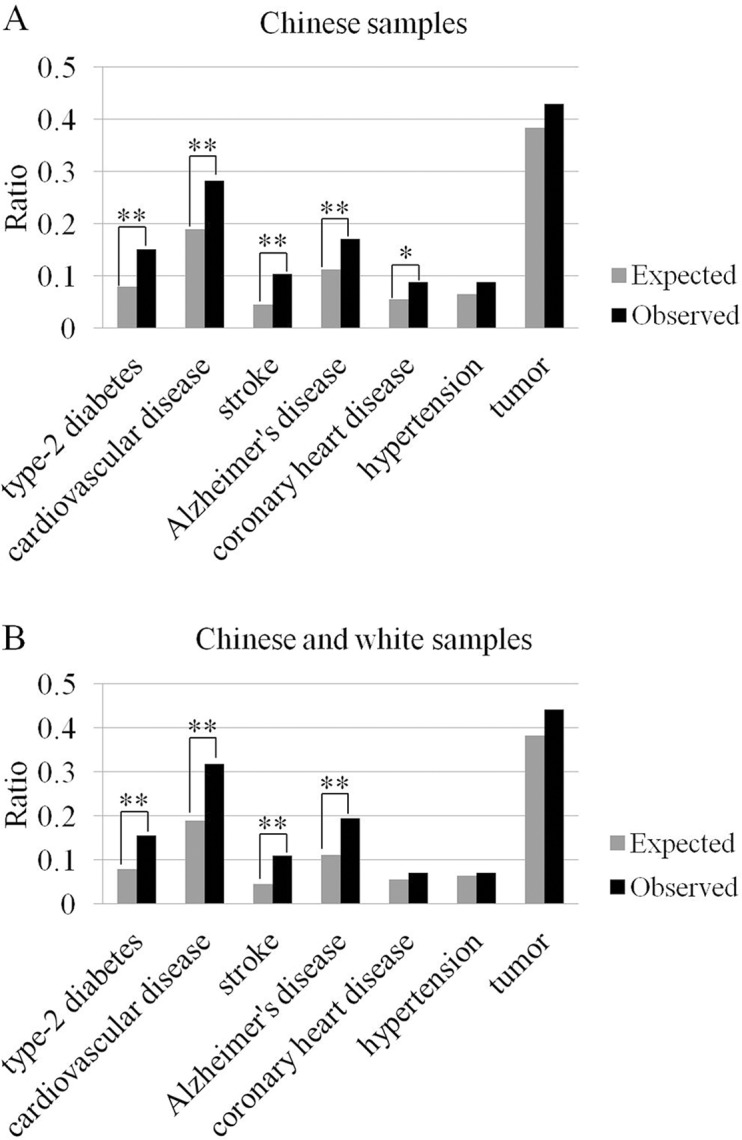
Gene set enrichment analysis (* p < 0.05; ** p < 0.01).(A) The gene set with DMRs in Chinese samples has a significant enrichment in age-related disease genes, including type-2 diabetes, cardiovascular disease, stroke, Alzheimer’s disease and coronary artery disease. (B) The gene set with DMRs in both Chinese and white samples is also enriched in age-related disease genes.